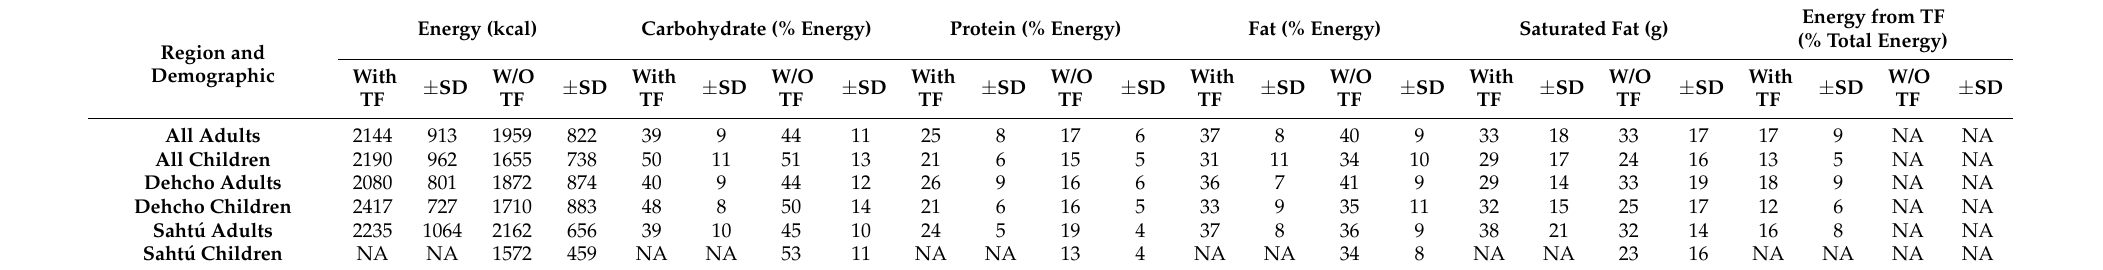
Table 1. Nutrient Intake According to the Consumption of Traditional Foods (TF); Mackenzie Valley Project 2016–2018 ( n = 197).